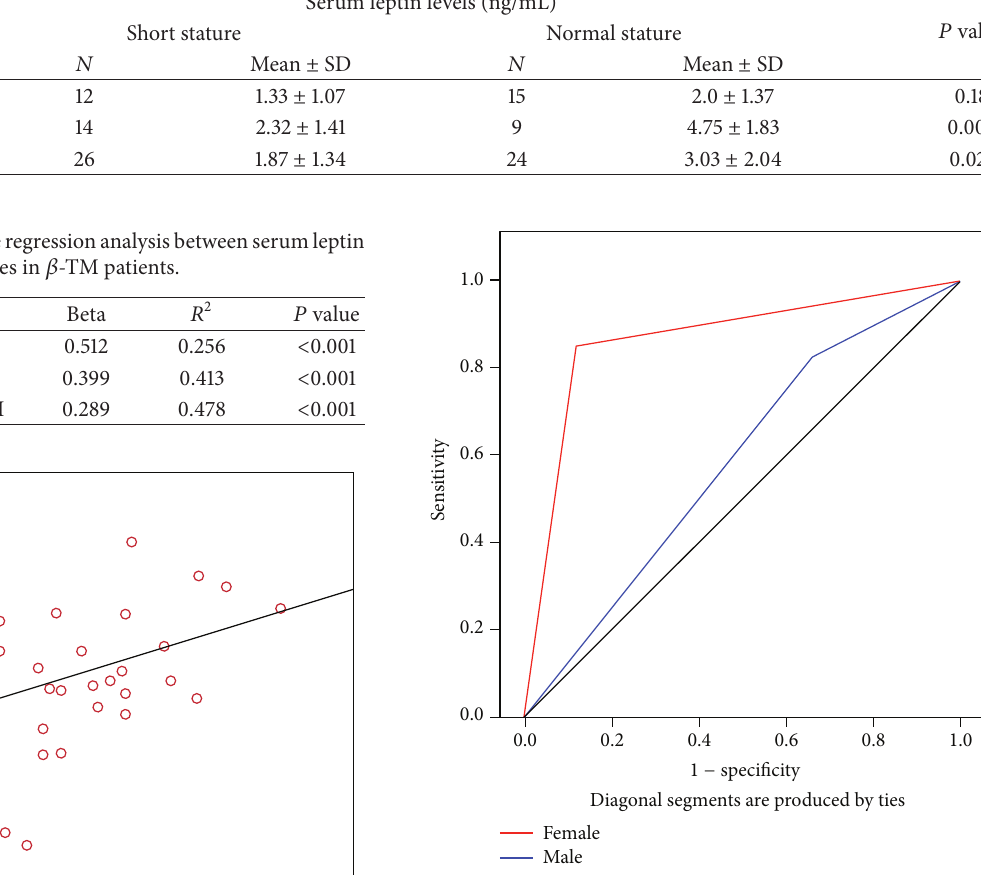
Figure 3: Receiver operating characteristic (ROC) curves of serum leptin levels and short stature in 𝛽 -TM patients using cut-off values mentioned in the text. The red and blue lines indicate female and male 𝛽 -TM patients, respectively. The AUCs ( ± SE) and 𝑃 values for female and male 𝛽 -TM patients are 0.822 ( ± 0.095), 𝑃 = 0.009 and 0.638 ( ± 0.116), 𝑃 = 0.265 ,